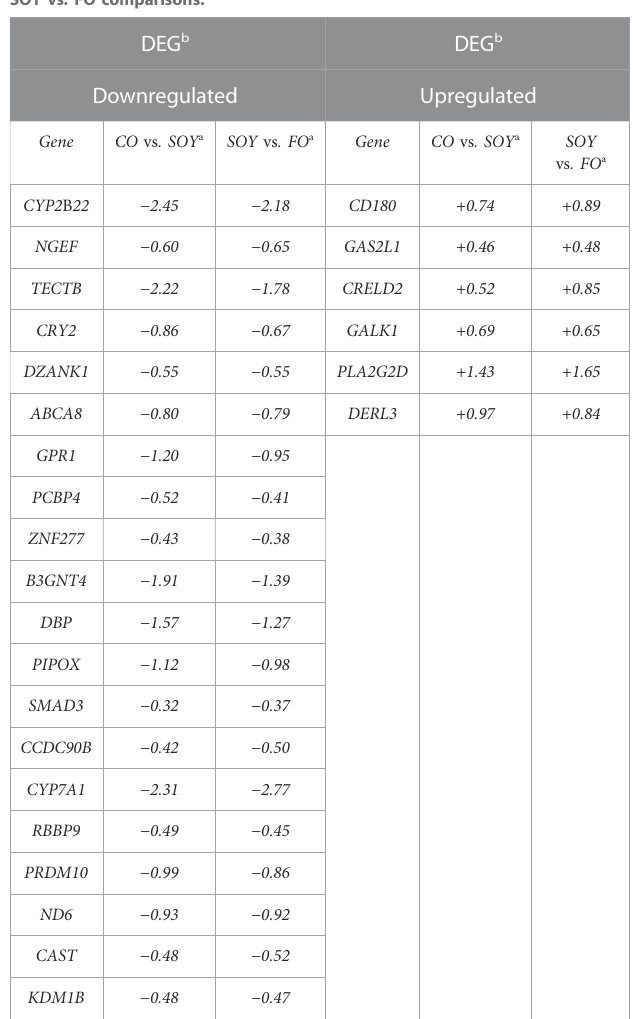
TABLE 3 Common differentially expressed genes between the CO vs . SOY and SOY vs . FO comparisons.